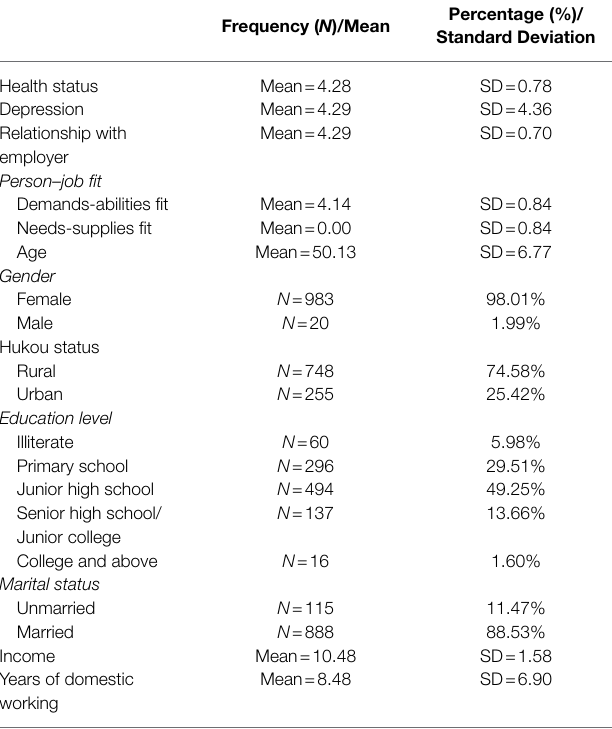
TABLE 1 | Descriptive characteristics ( N =